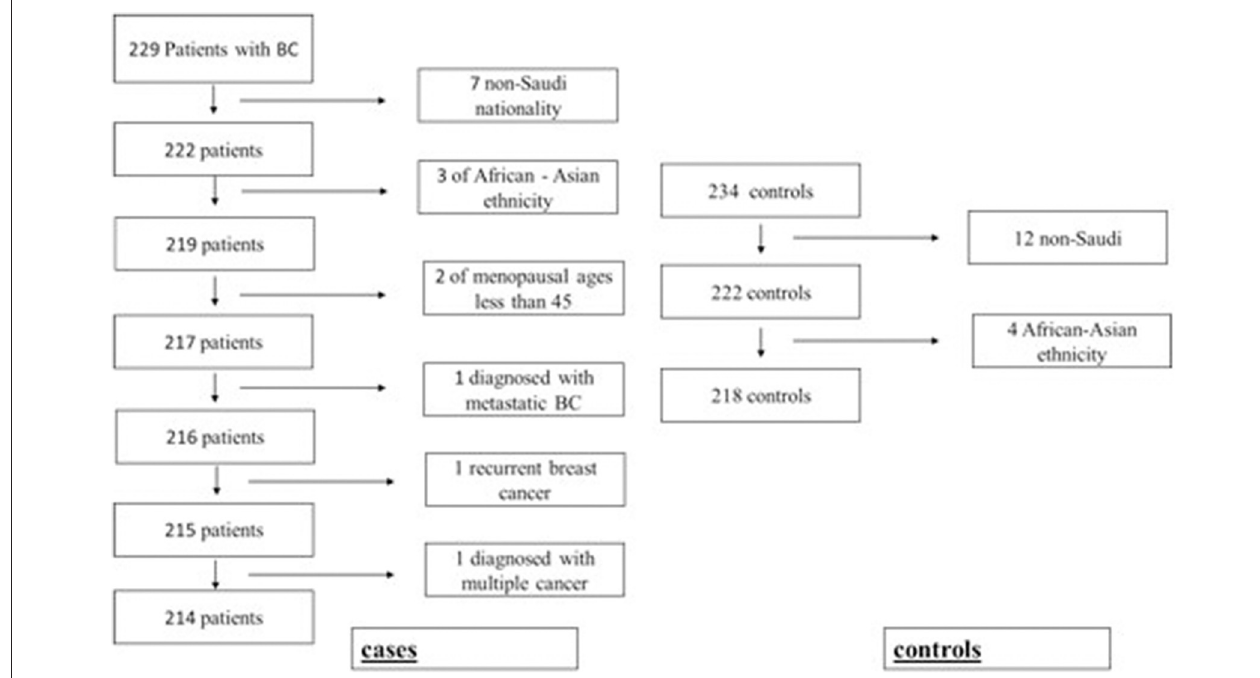
FIGURE 1 | Flowchart for recruiting cancer patients and control group